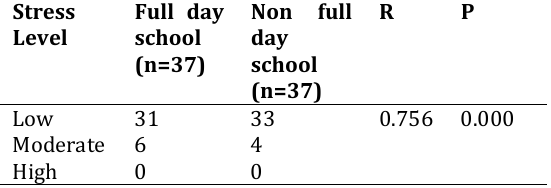
Table 4 Overview of the Lambda Correlation